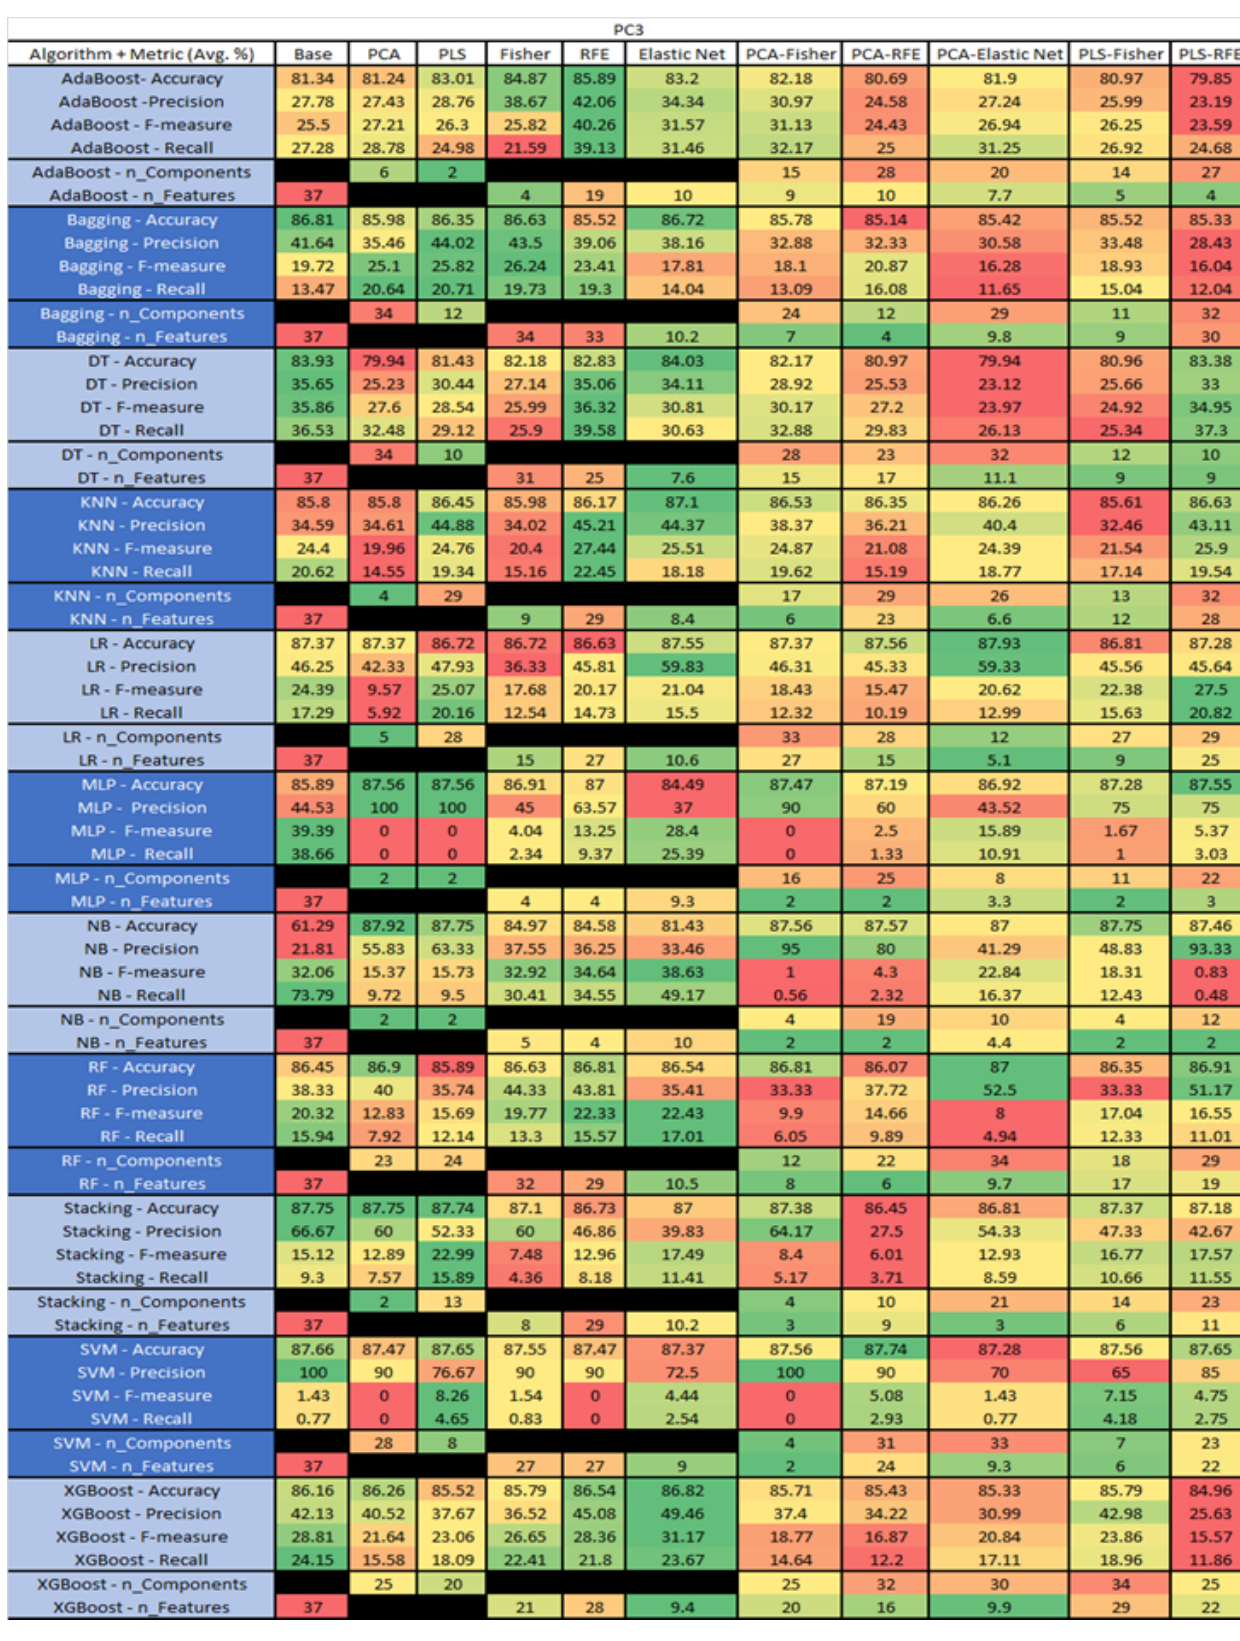
Figure 44. PC3 NASA MDP Results Data